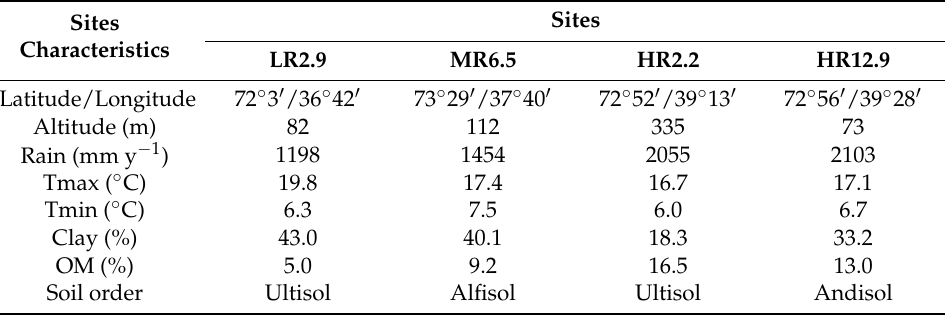
Table 1. Mean annual rainfall (Rain), mean annual maximum temperature (Tmax), mean annual minimum temperature (Tmin), clay content (Clay), and organic matter (OM), in the first 20 cm of soil depth for each